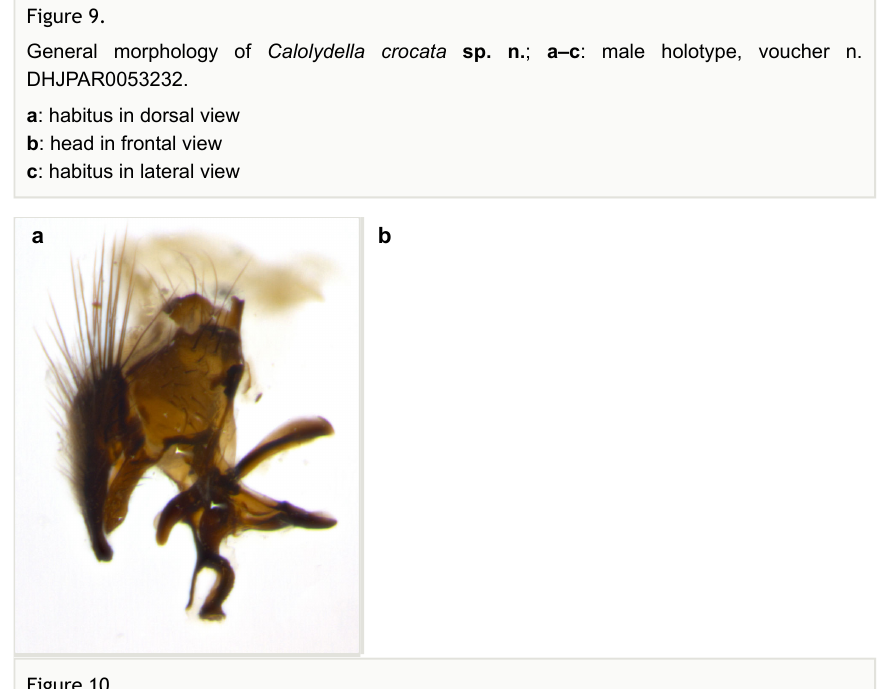
discal setae. Terminalia (Fig. 10): sternite 5 (Fig. 10c) with two small lobes and a wide U-shaped median cleft, 0.39X the length of the sternite from lobe to apex; inner margin covered by dense pollinosity, appearing darker than surrounding cuticle; upper margin of sternite with many stout, outwardly-pointing setae. Cerci (Fig. 10b) separated by a narrow gap basally, widening to an oval about midway; cercus, in dorsal view, long and rounded and not significantly tapering from base to tip; cercus, in lateral view, straight and setose along basal half, with a slight bulb at its tip. Surstylus (Fig. 10a) short, 2/3 length of cercus, and knife-like, appearing sharply pointed when viewed laterally; apical half of surstylus with short setae; tip of surstylus slightly angled outwards when viewed dorsally.